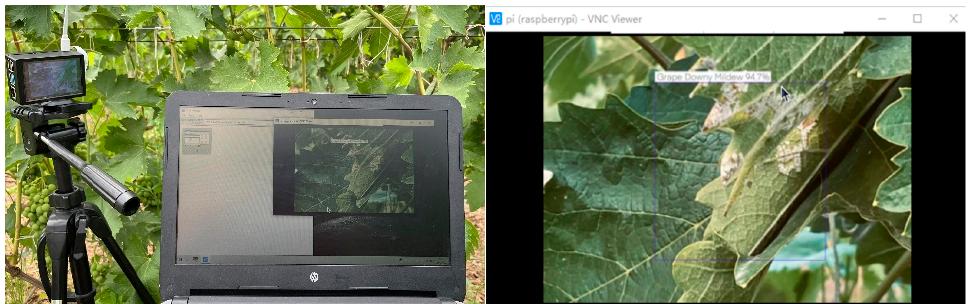
Figure 12. Functional validation of remote real-time detection of grape pests and diseases.